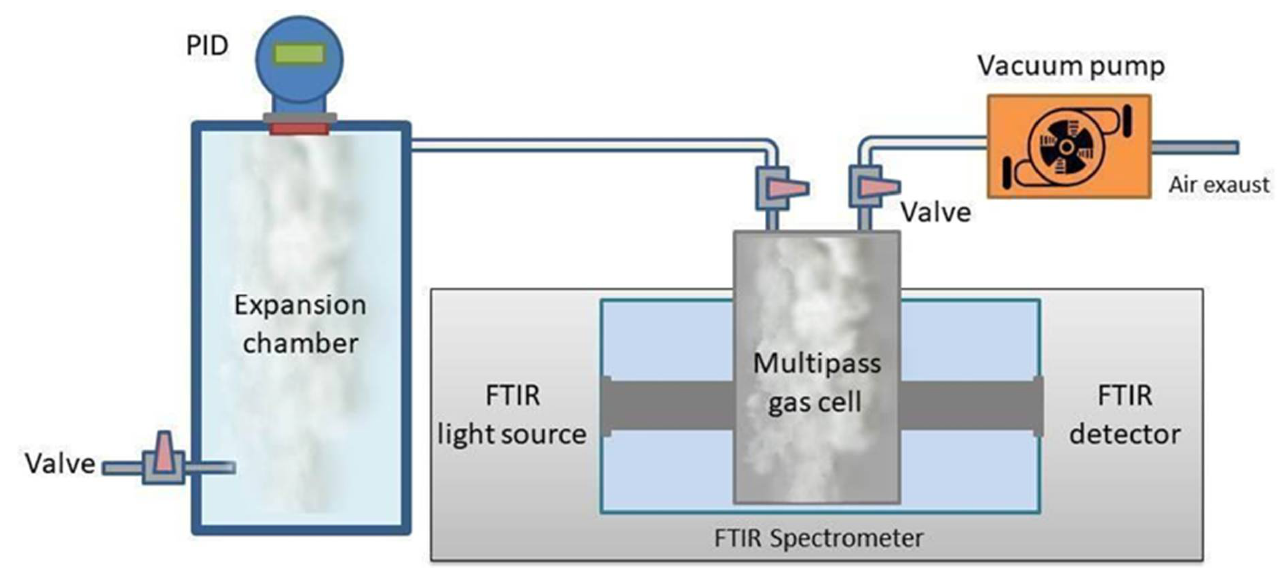
Figure 1. Schematic view of the setup used for the calibration experiments. The multipass gas cell, located in the sample compartment of a Vertex 70v Michelson interferometer, was connected to a sealed evaporation chamber. The PID system was installed on top of the evaporation chamber and was connected to a computer for real-time monitoring of evaporated VOCs.